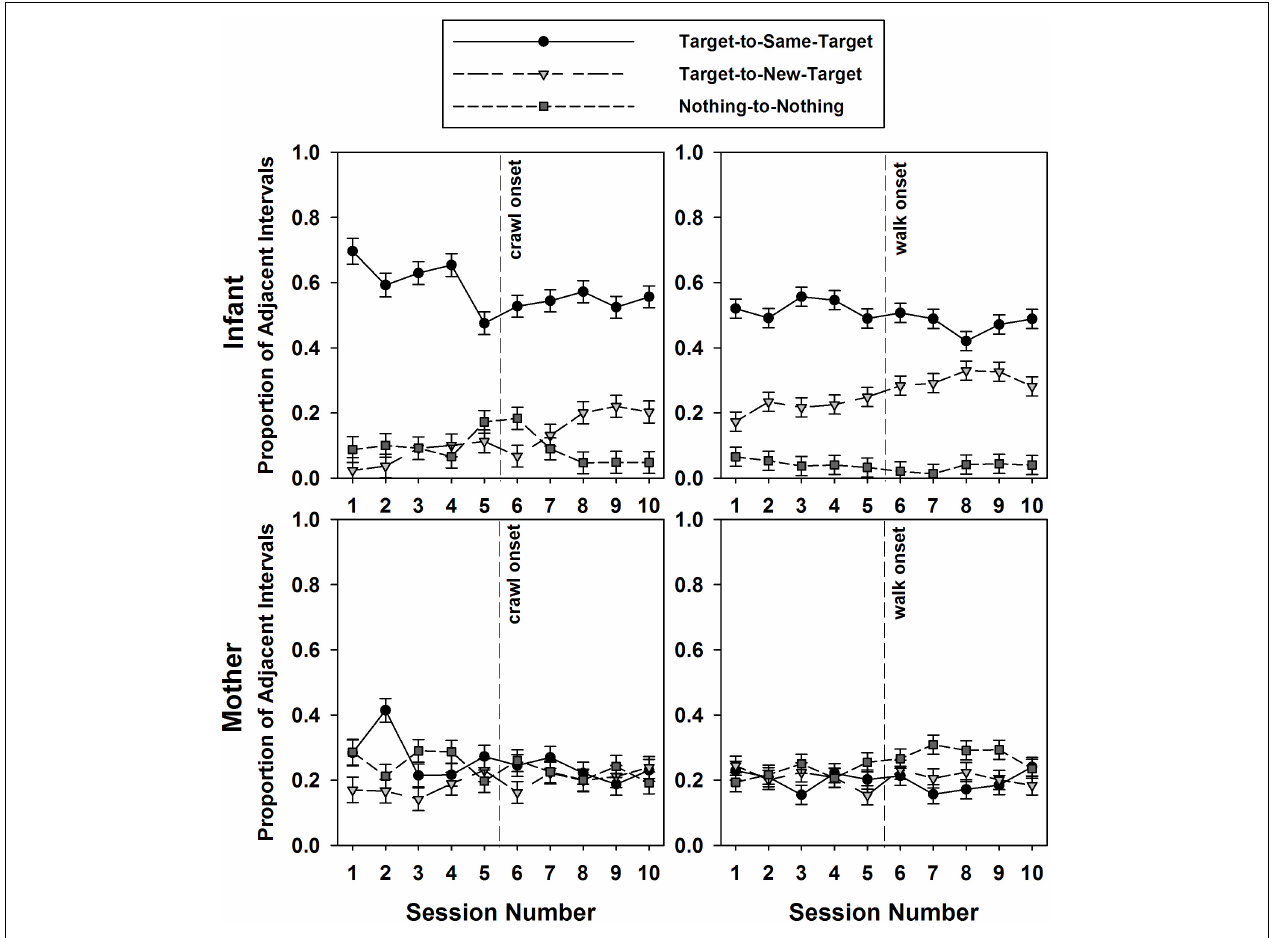
FIGURE 8 | Mean proportions and standard errors of infants’ (top) and mothers’ (bottom) target transitions by type and by session number. The graphs represent the 10-session transition around crawling (left) and walking (right), with vertical lines indicating the onsets of crawling and walking,